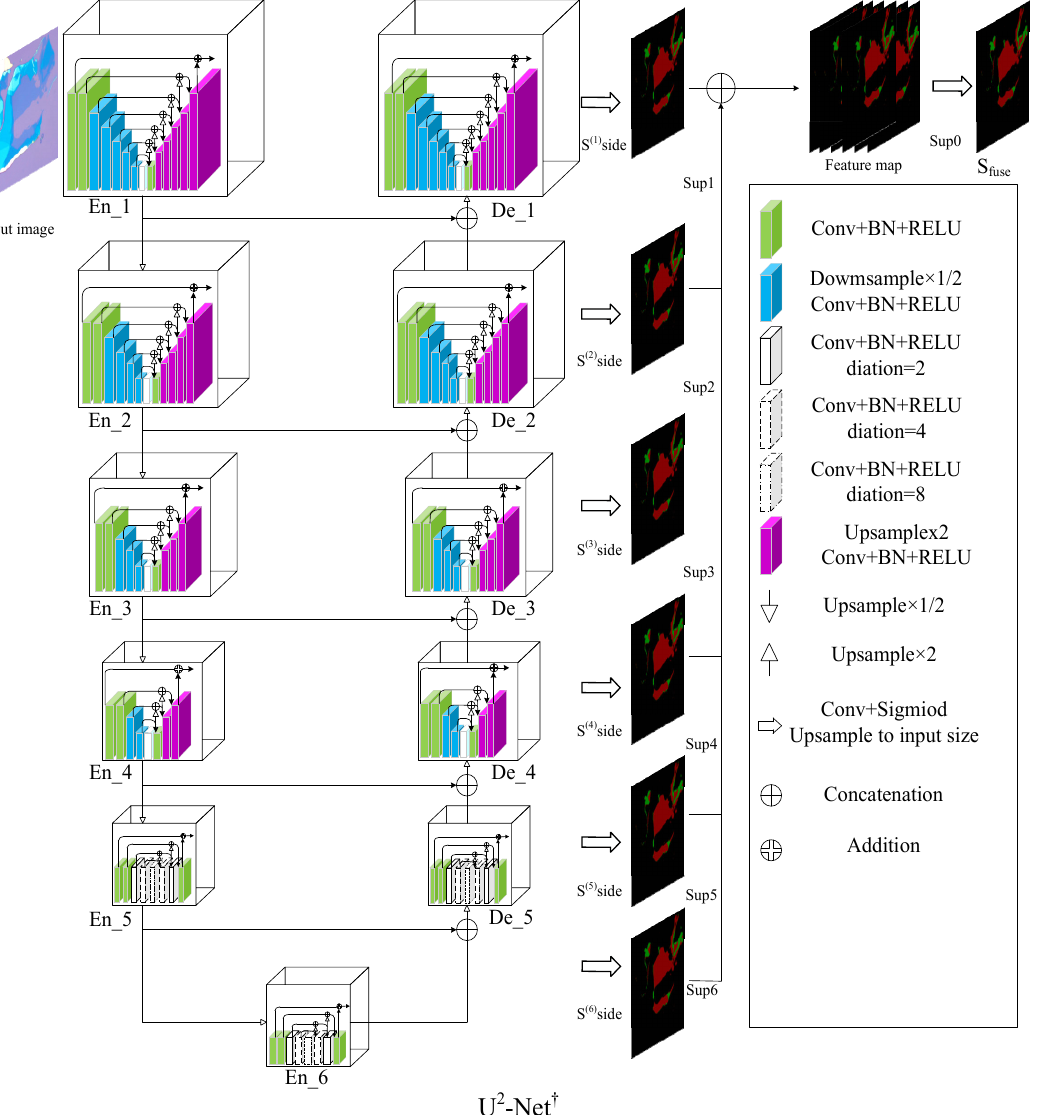
2 -Net † model Figure 1. U 2 ‐ Net † model structure. Figure 1. U